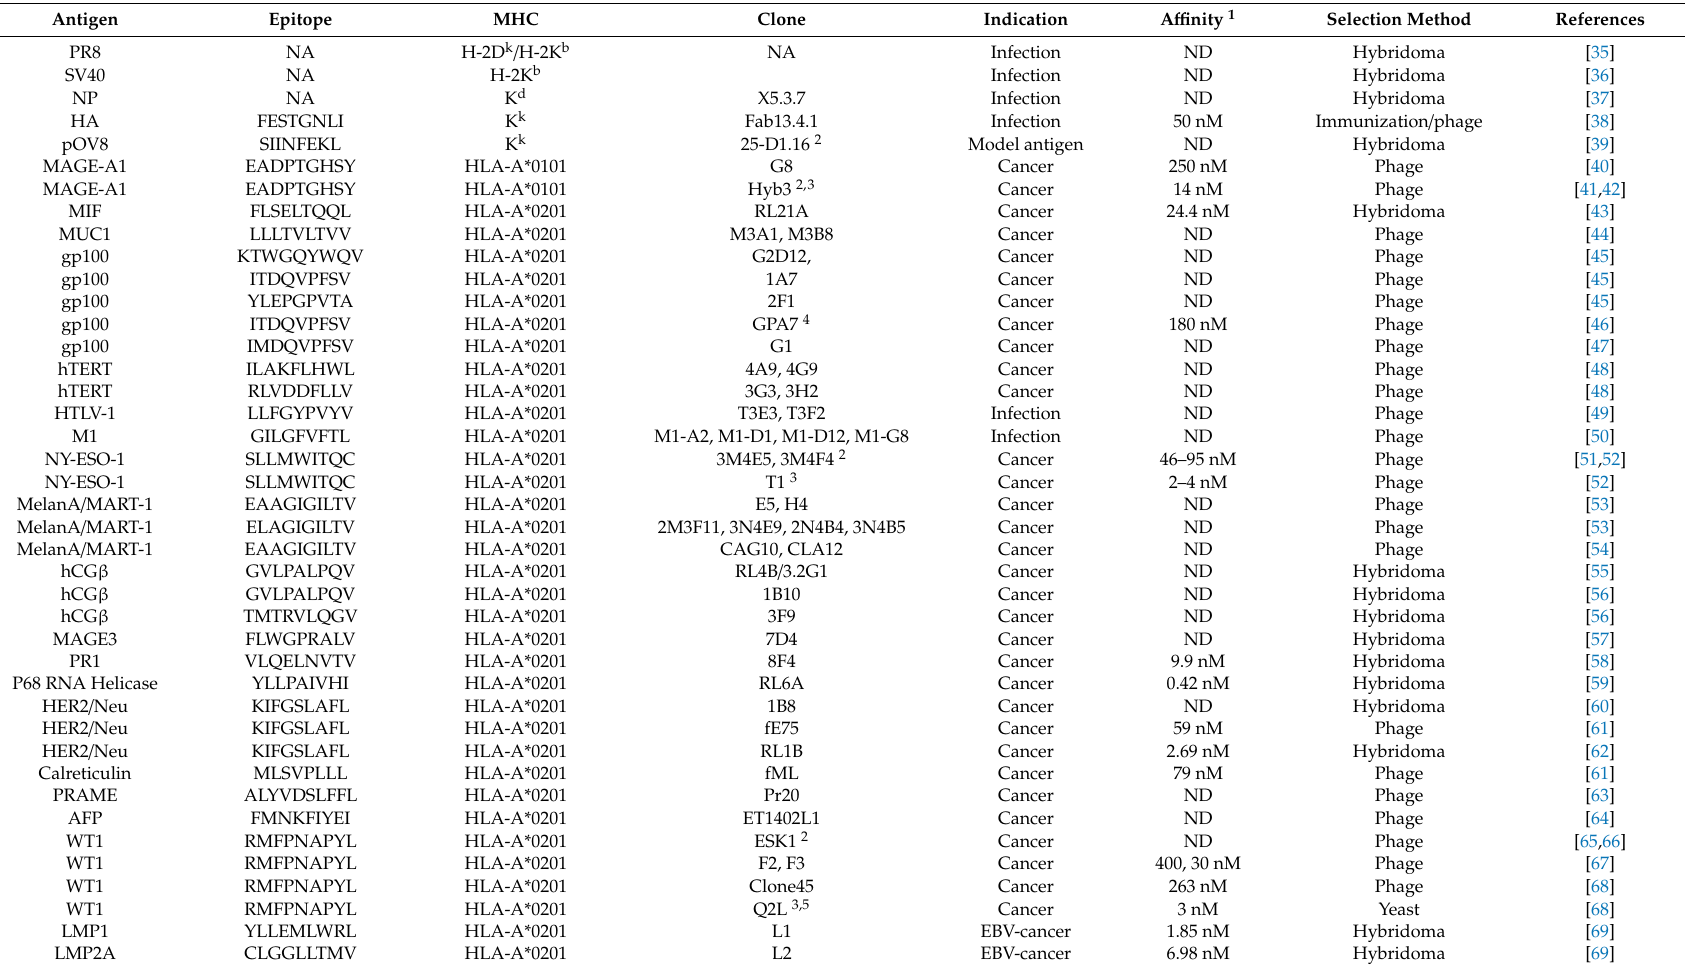
Table 1. T-cell receptor (TCR)-like monoclonal antibodies (mAbs) against peptide–major histocompatibility class I